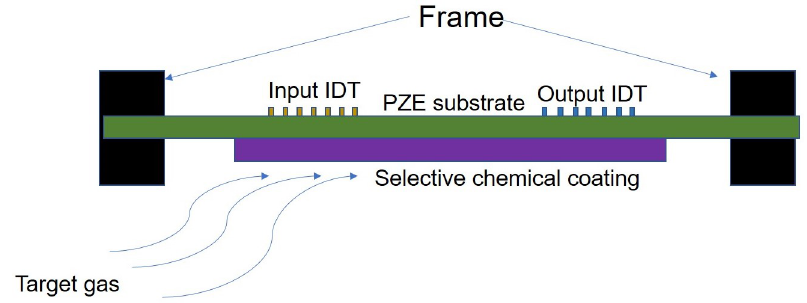
Figure 11. Cross-sectional view gas of sensor using a PVDF substrate